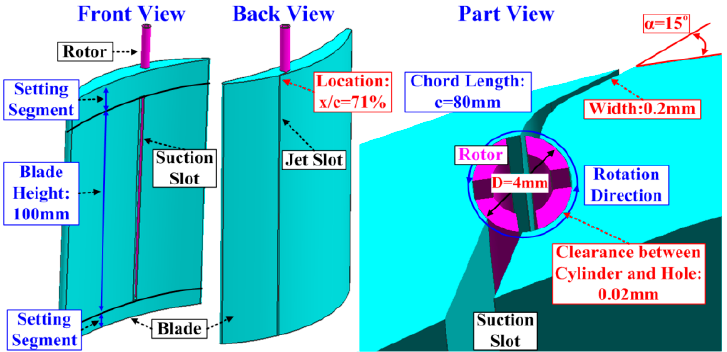
Figure 3. Schematic diagram of electromagnetic pulsed jet.